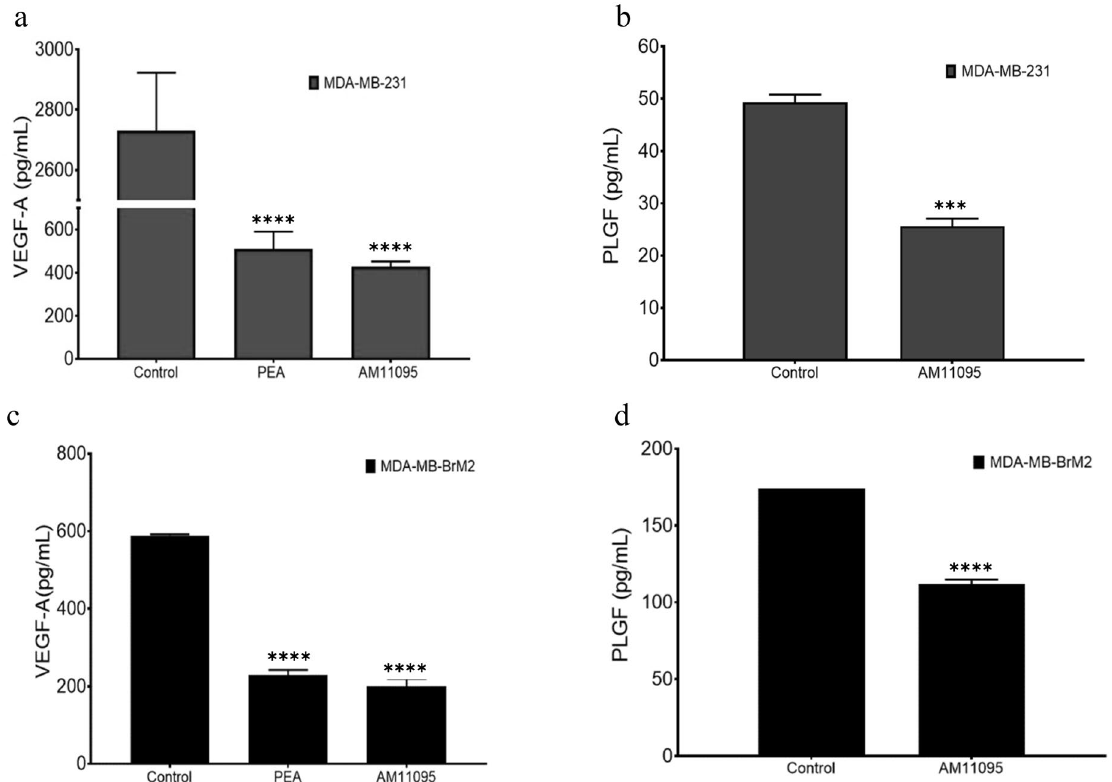
Figure 4. ( a )–( d ) Angiogenesis Bead-Based Multiplex Assays: The levels of the angiogenesis factors in culture supernatants of MDA-MB-231 (panels: a , b ) and MDA-MB-BrM2 (panels: c , d ) cells with notable differences between AM11095-treated samples vs. vehicle control -treated samples. Each factor is listed on the Y-axis of the corresponding graph. The concentrations were assayed with Luminex kit (MILLIPLEX). Data were adjusted for background, and then the observed concentrations were plotted on a log–log scale. Error bars were calculated using the coefficient of variation (%CV) for each sample from all bead fluorescence intensities between 5th centile and 95th centile (trimmed bead %CV). The p-values were calculated by Unpaired Student’s reduced following treatment with AM11095 (Fig. 6a). The MRI images revealed the mean volume in untreated tumors and vehicle treated groups were twofold and threefold increase respectively, as compared to the mean in nude mice treated with AM11095 (Fig. 6b). Further, the mean number of tumors in untreated mice and vehicle control treated mice were approximately 2 times greater than in nude mice treated with AM11095 (Fig. 6c). On day 28, the mean number of tumors per mouse was significantly lower and no tumor burden was observed following treatment with AM11095 (Fig. 6c). Importantly, while there was no difference in survival between the two groups of mice (untreated and vehicle control), an increase in the survival of mice were observed when mice were treated with AM11095 (Fig. 6d). Thus, AM11095 may have a survival benefit in mice in addition to its inhibiting tumor growth in vivo. Tumor sections analysis, hematoxylin–eosin (H&E) staining and immunostaining: In the untreated tumors, there was extensive (~ 60%) necrosis within the mass, particularly within central regions of cell growth (Sup- plemental Fig. S2-B). The tumors were moderately heterogeneous with poorly differentiated individual cells, cell clusters, and spindloid components within a thin fibrous network (Supplemental Fig. S2-C, representative images). Some borders of the tumors were well demarcated but with regional invasion of the adjacent adipose tissue and lymphatic vessels (Supplemental Fig. S2-D and 2-E, representative images). Individual tumor cells were pleomorphic exhibiting moderate anisocytosis and anisokaryosis, occasional large pleomorphic nuclei, and dark basophilic stippled chromatin with occasional giant cells present. There were frequent mitoses, and occasional bizarre mitotic figures (Supplemental Figure S2-F, representative images). There was also a mild mixed (mostly neutrophilic) inflammatory infiltrate within the tumor stroma and adjacent tissues (Supplemental Fig. S2-E). In the AM11095 treated tumors, there was extensive (~ 50%) necrosis within the mass, and the tumors were moderately heterogeneous with poorly differentiated individual cells, cell clusters, and spindloid components within a thin fibrous network (Supplemental Fig. S3-C, representative images). Interestingly, there was no clear invasion of tumor cells beyond the surface of the tissue. The Individual tumor cells were pleomorphic exhibit- ing moderate anisocytosis and anisokaryosis, occasional large pleomorphic nuclei, and dark basophilic stippled chromatin with occasional giant cells and signet ring-like cells present (Supplemental Fig. S3-D). Interestingly, there was less infiltrated immune cells (mostly neutrophilic), inflammatory infiltrate within the tumor stroma and adjacent tissues. However, immunohistochemistry analysis of tumor cells with specific antibodies for IL-6